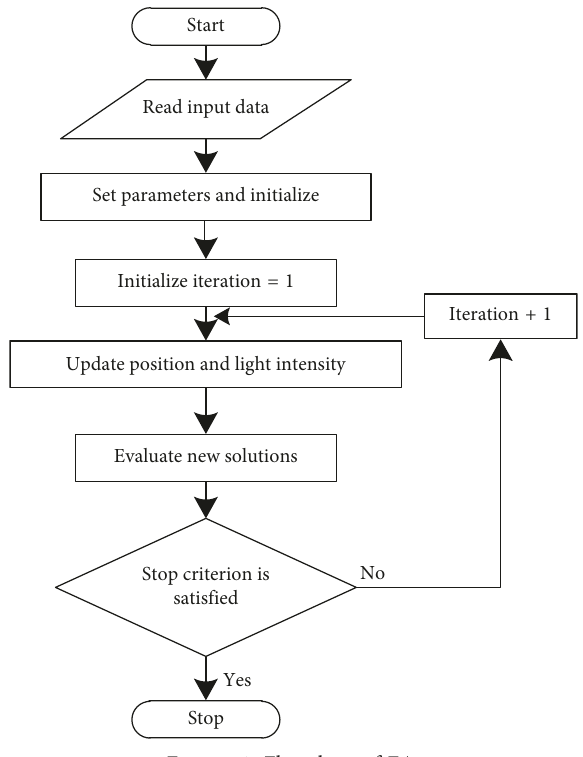
Figure 1: Flowchart of